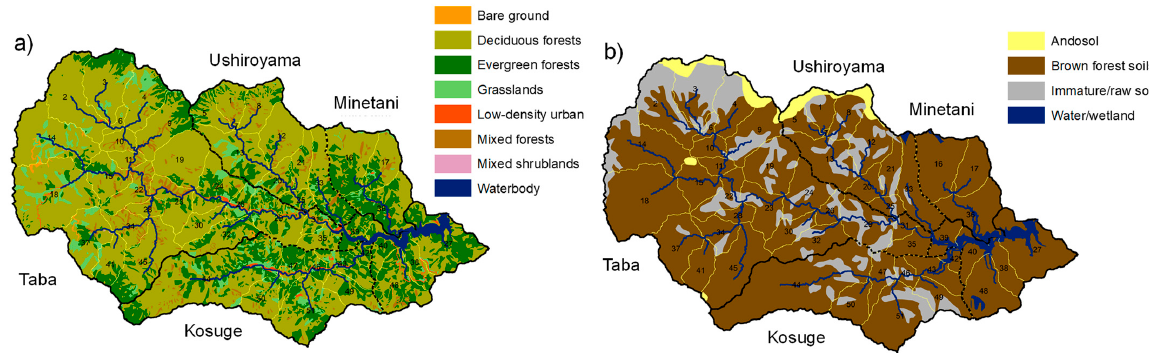
Figure 3. Geographical inputs in SWAT: ( a ) 2013 land-cover map and ( b ) 2019 soil map. The monthly discharge calculation prior to parameter adjustment was evaluated using five statistical indices namely Nash – Sutcliffe efficiency (NSE), root mean square error (RMSE), percent bias (PBIAS), mean absolute error (MAE), and coefficient of determination (R 2 ). Using Table 1, the performance ratings were evaluated based on the computed values of recommended statistical indices [51]. Table 1. Performance ratings for recommended statistical indices for evaluating monthly discharge simulations in SWAT.